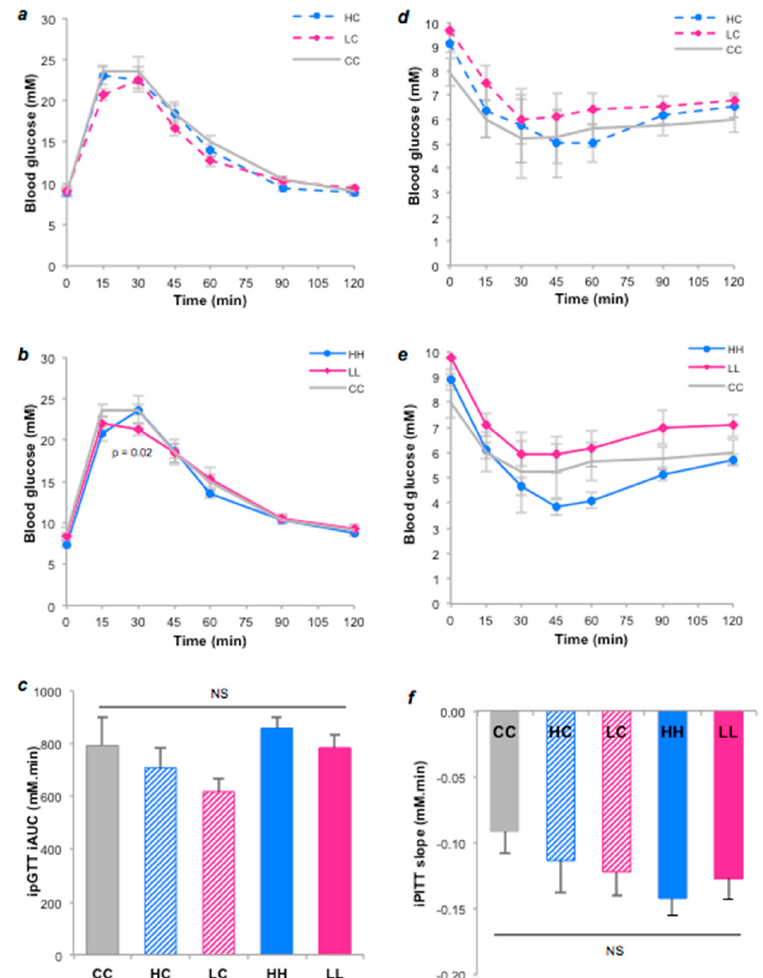
Figure 3. Metabolic responses to the intraperitoneal glucose tolerance and insulin tolerance tests in 17–18 week old offpring fed 5 different diets. Blood glucose responses ( a, b ) and iAUC ( c ) after glucose injection. Blood glucose responses ( d , e ) and the slope of blood glucose change in first 30 mins ( f ) in response to intraperitoneal insulin injection. Data represent the Mean ± SEM. NS = not significant. For glucose tolerance tests: CC n = 8, HC n = 10, HH n = 10, LC n = 13, LL n = 10. For insulin tolerance tests: CC n = 7, HC n = 7, HH n = 12, LC n = 7, LL n = 10.